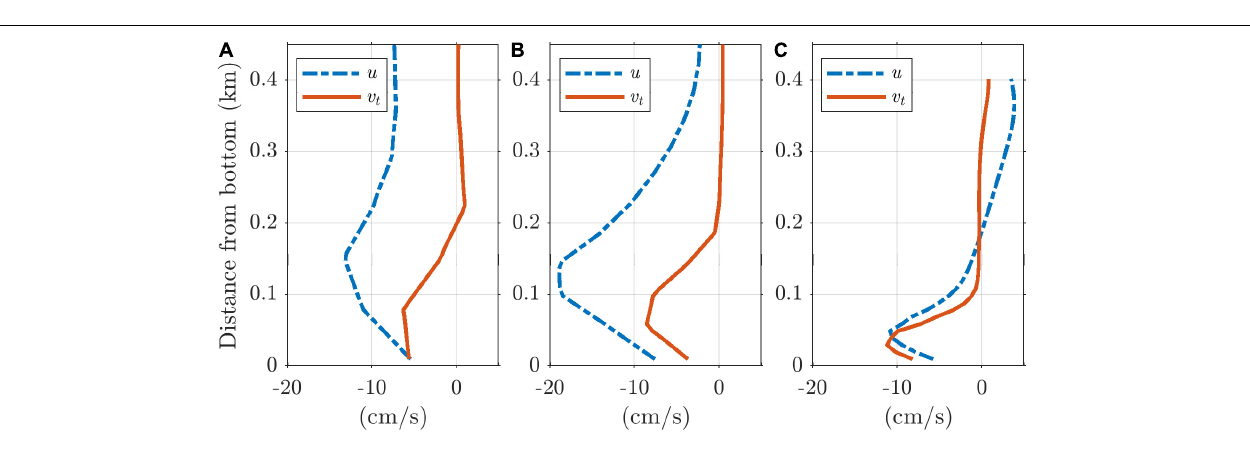
FIGURE 9 | Profiles of zonal and downslope velocities near the slope bottom in the SCS experiment on day 20. (A) y = 80 km, (B) y = 85 km, (C) y = 90